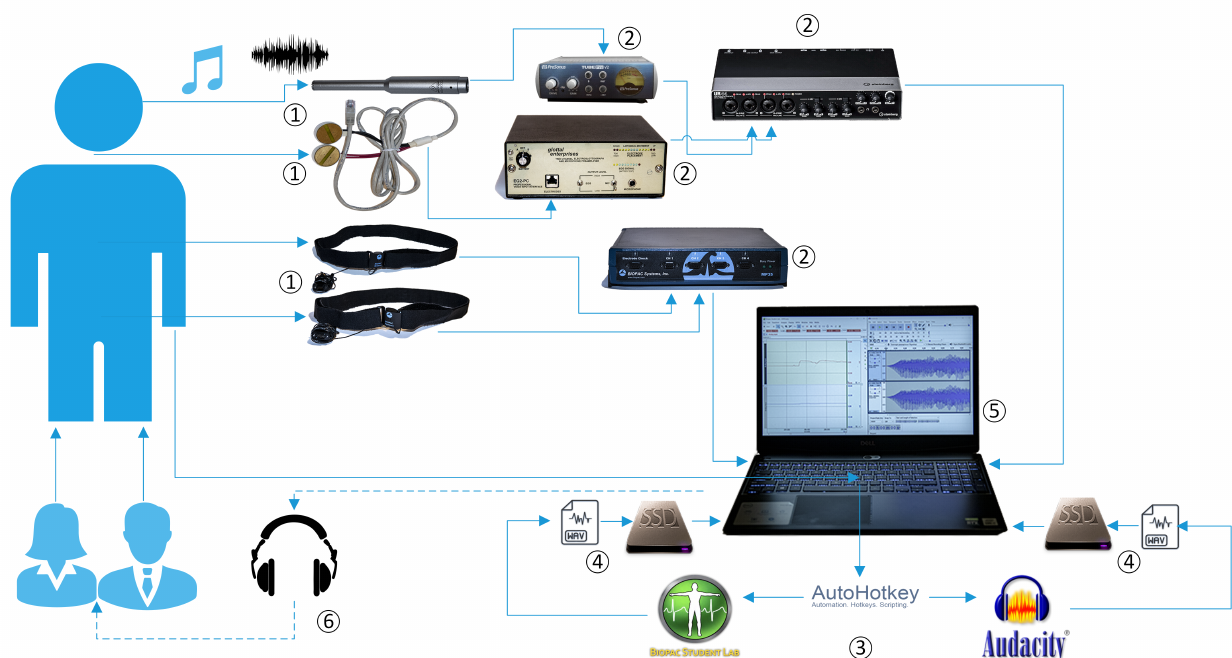
Figure 3. System Architecture: 1 (cid:13) Sensors. 2 (cid:13) Signal Acquisition and Amplification Units. 3 (cid:13) Data Recording Synchroniza- tion. 4 (cid:13) File Export and Storage. 5 (cid:13) Data Analysis. 6 (cid:13) Post hoc Perceptual